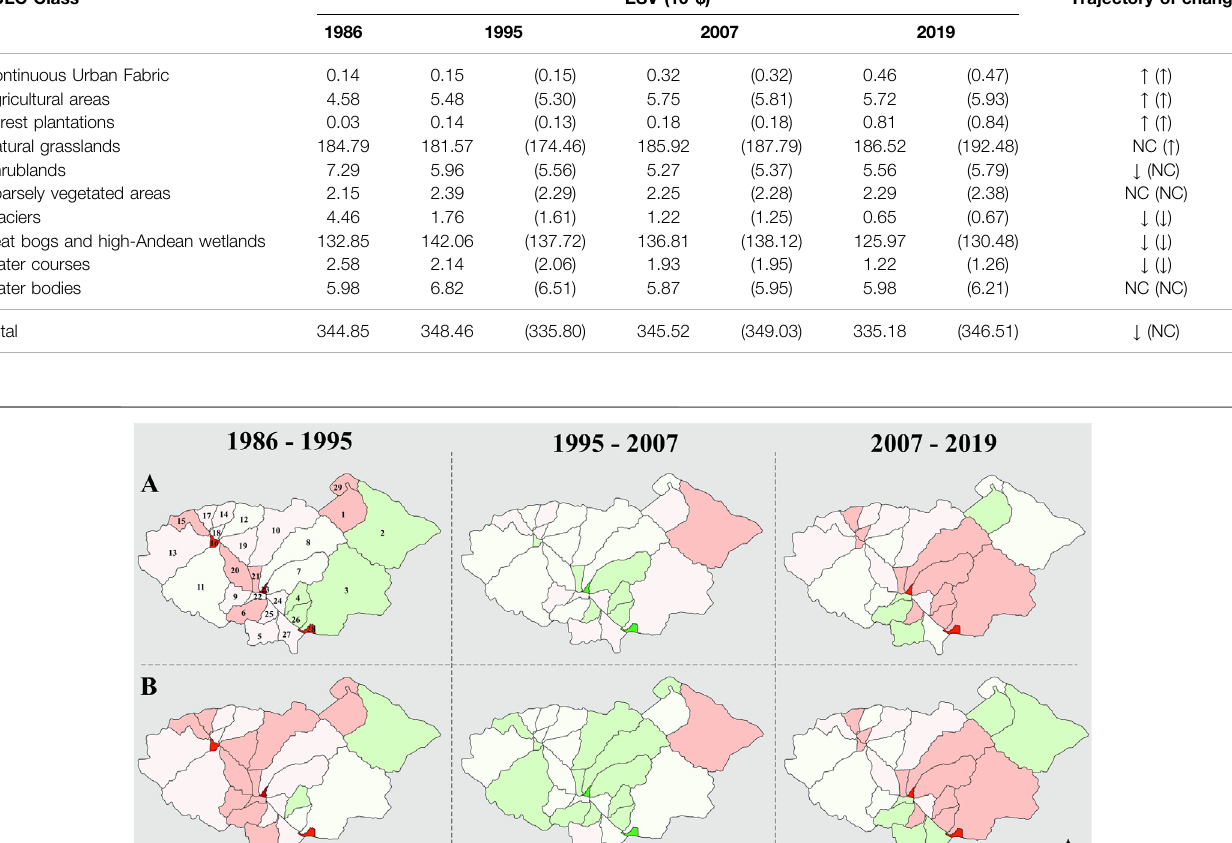
TABLE 5 | ESV of each LULC at the municipality level between 1986 and 2019 and the overall trajectory of change. The values in parentheses represent the adjustment by the in fl ation. Top arrow for the increase and down arrow for decrease. NC = no change. Trajectories in parentheses include values from in fl ation adjustment. LULC Class